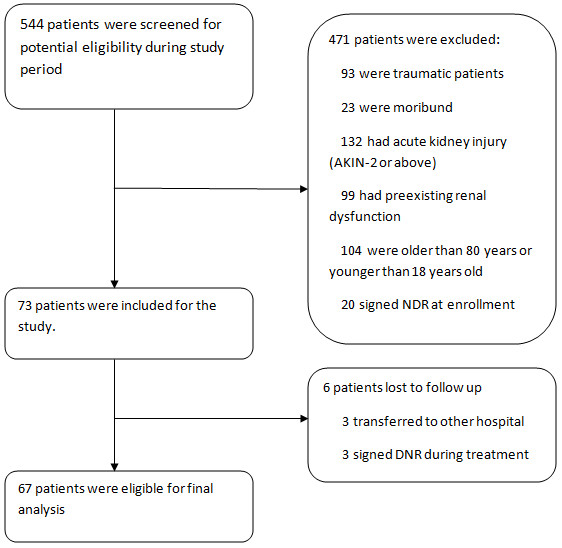
Flow chart of patients selection.